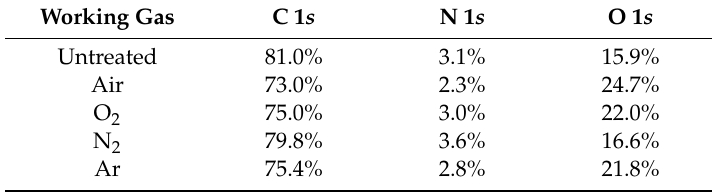
Table 1. Surface elemental composition of PU plasma treated in di ff erent gases. Working